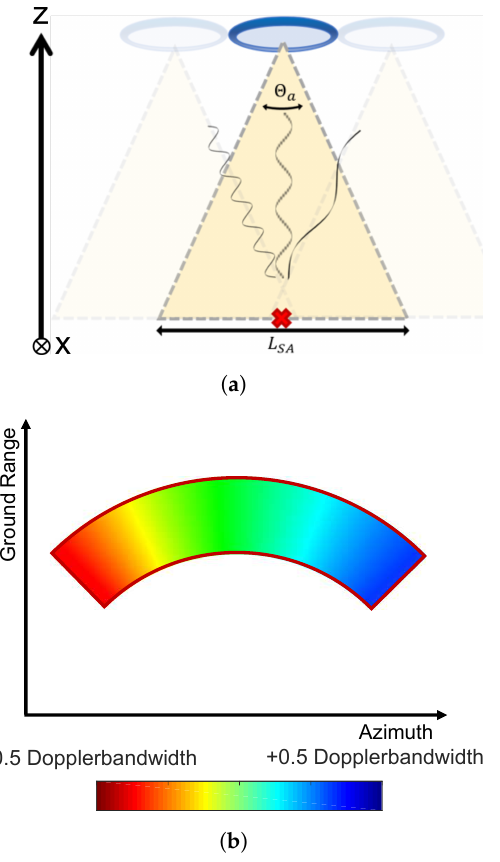
Figure 2. ( a ) The beamwidth in azimuth allows the SAR to record the Doppler chirp caused by the relative motion between radar and target (red mark). ( b ) Two-dimensional ground extent. The Doppler frequency is directly related to the azimuth